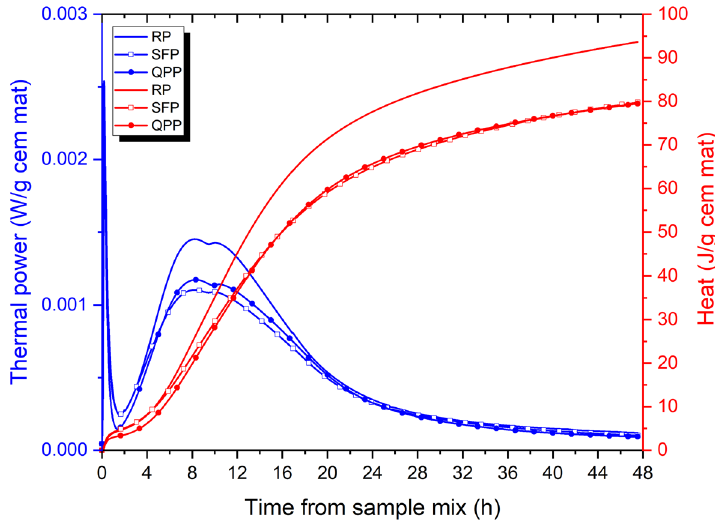
Figure 2. Thermal power and accumulated heat curves of RP, SFP and QPP